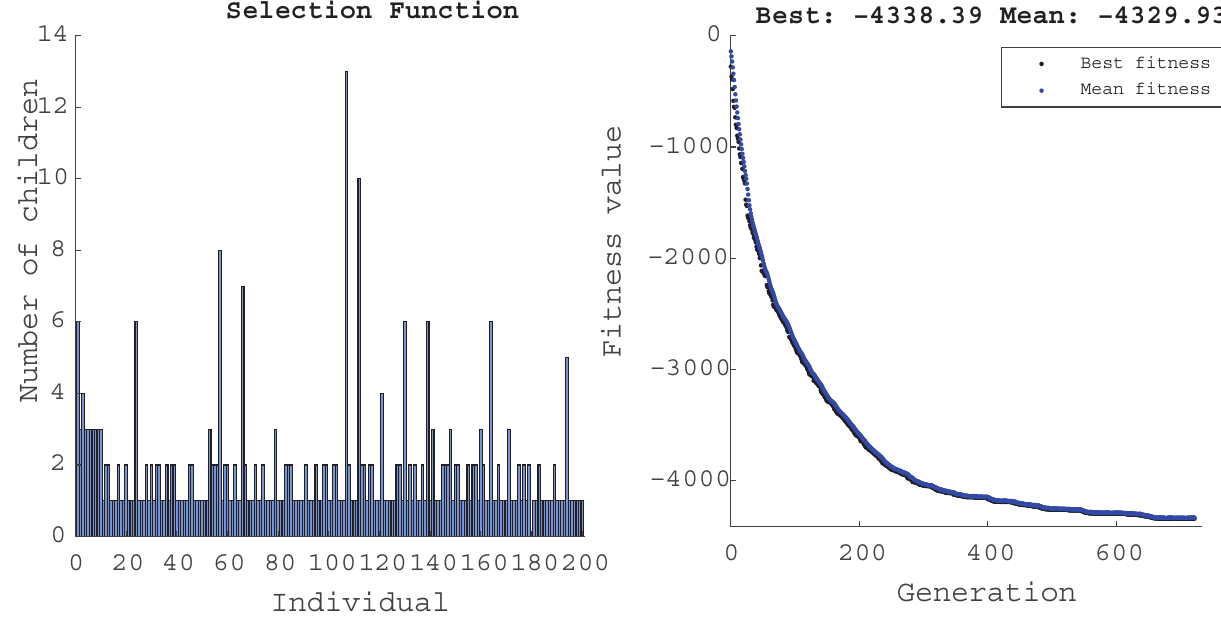
Figure 12. Selection and fitness functions from GA for summer (26 July 2019). Selection Function